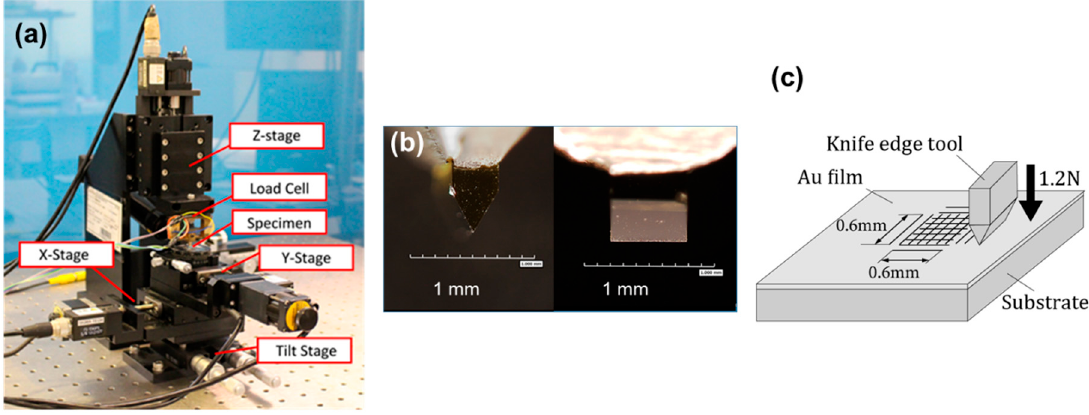
Figure 1. Schematic illustration of proposed fabrication process.